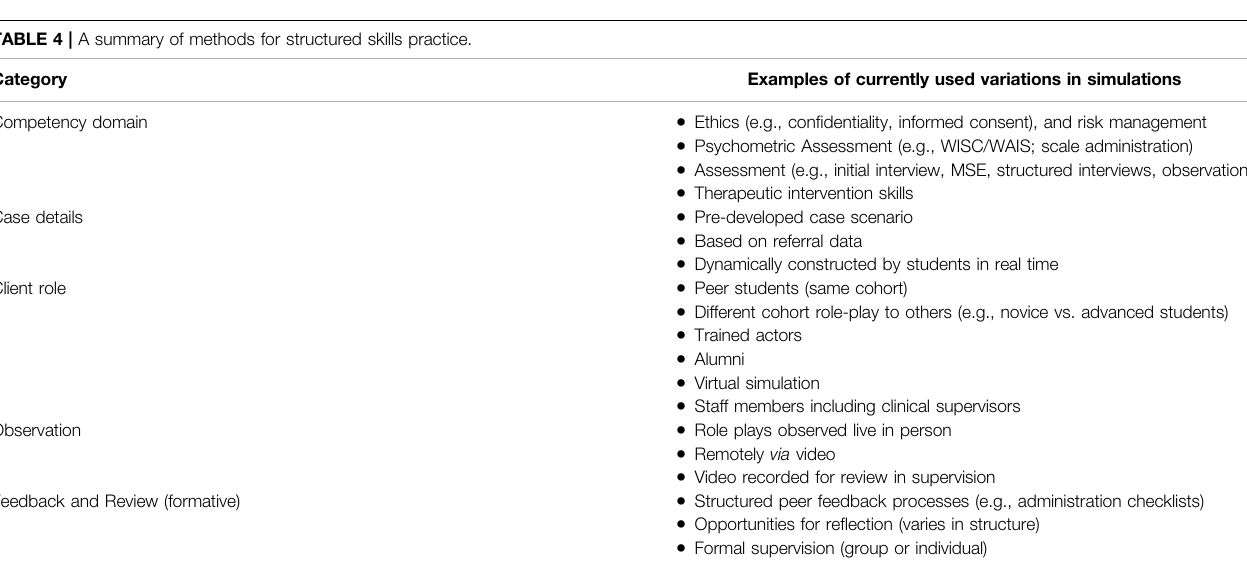
TABLE 4 | A summary of methods for structured skills